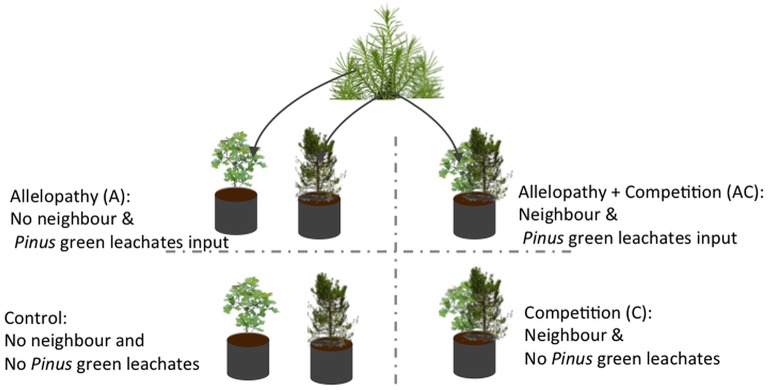
Diagram of factorial design utilized for experimentation. Three interference treatments and one control were tested on Pinus and Quercus saplings: allelopathic treatment was applied by application of Pinus needle aqueous extract; competition treatment through neighbor presence; allelopathy + competition treatment through neighbor presence plus application of Pinus needle aqueous extract; and control treatment.